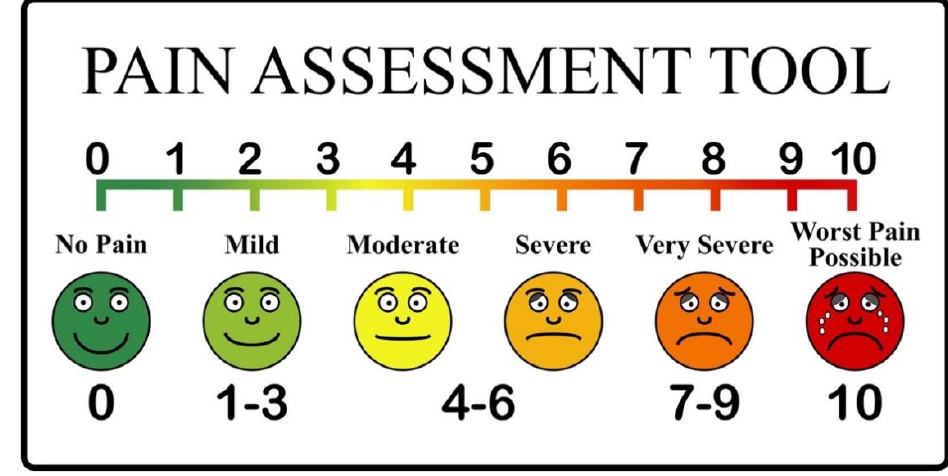
Figure 1. Pain Scale Chart: 1 to 10 Levels.